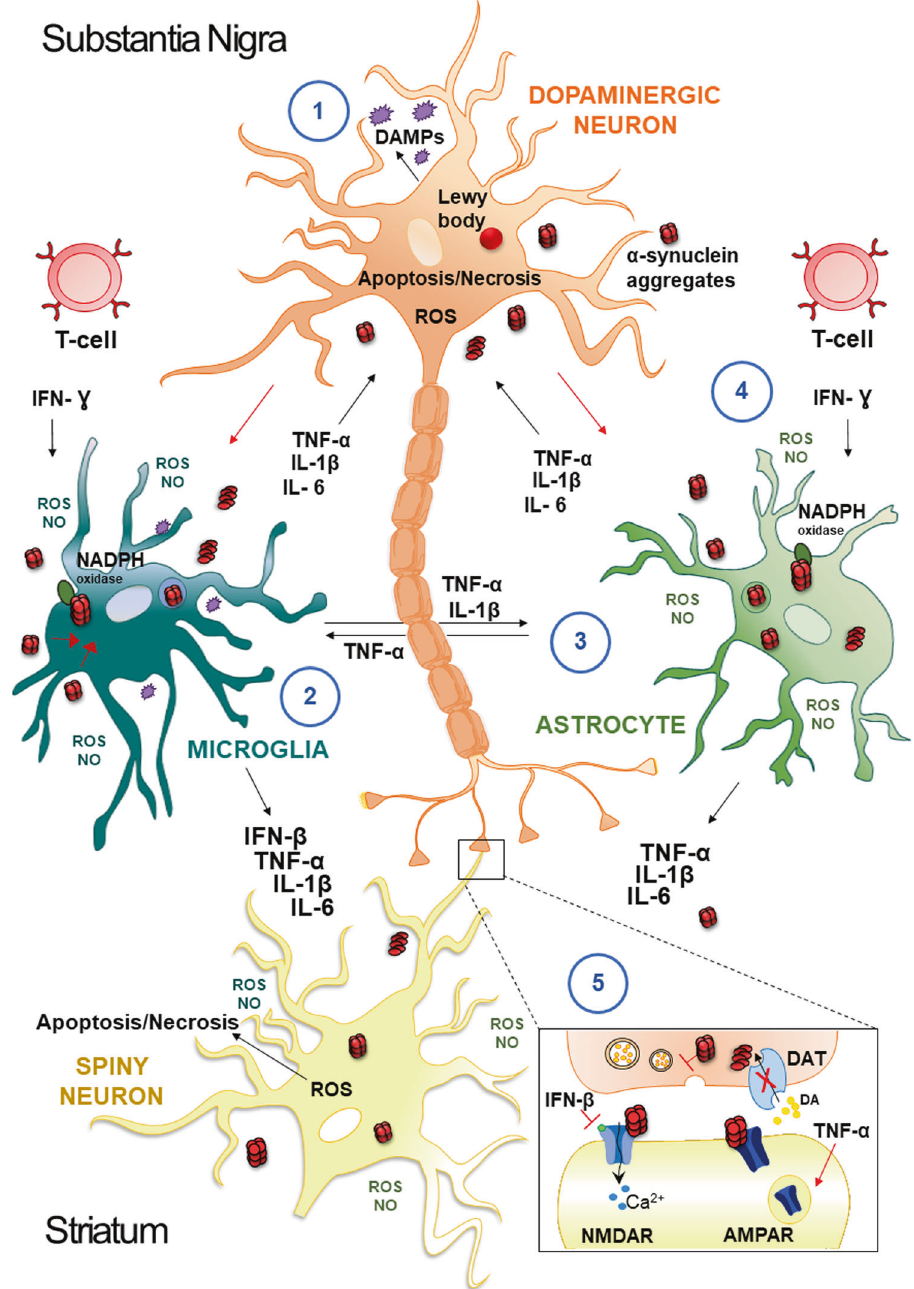
Fig. 2 Mechanisms underlying in fl ammation in PD. Neuropathological hallmarks of PD are the presence of intracellular inclusions containing α -syn aggregates and the death of dopaminergic neurons in the SNpc of the midbrain. Damage-Associated Molecular Patterns (DAMPs), are endogenous danger molecules released from damaged or dying cells, resulting in microglia activation and persistent neuroin fl ammation (1). Extracellular aggregates of α -syn released by neurons activate glial cells; the internalization of α -syn is followed by activation of NADPH oxidase with the production of ROS/NO, and by the release of proin fl ammatory cytokines (TNF- α , IL-1 β , IL-6, IFN- β ) (2). In addition, activated-microglial cells produce mediators such as TNF- α and IL-1 β that activate astrocytes, which in turn secrete other cytokines (TNF- α , IL-1 β , IL-6) (3). These factors act on dopaminergic neurons of the SNpc and spiny neurons of the striatum and further activate microglia, amplifying the in fl ammatory response in a positive feedback loop. In particular, IFN- γ is secreted by T cells and is a cytokine involved in the death of DA neurons in the development of PD, which is responsible for enhancing the activation of the surrounding glial cells (4). In this scenario, soluble immune molecules can in fl uence the modulation of synaptic transmission and plasticity (5). For example, INF- β in fl uences NMDAR-mediated synaptic currents in spiny neurons. Conversely, TNF- α drives the internalization of AMPARs and reduces corticostriatal synaptic strength and results in a preferential removal of Ca 2 + -permeable AMPARs.